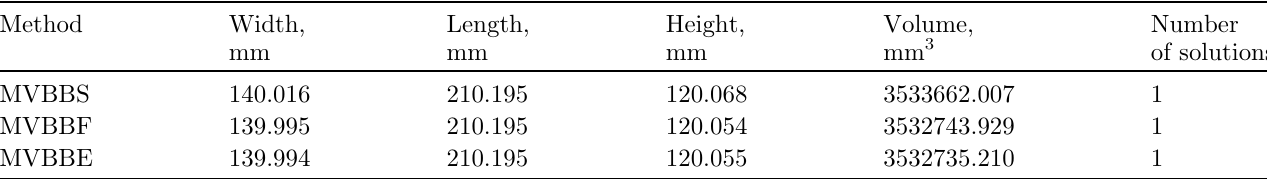
Table 3. The computation results of the MVBBS, MVBBF, MVBBE methods for the second test. Method